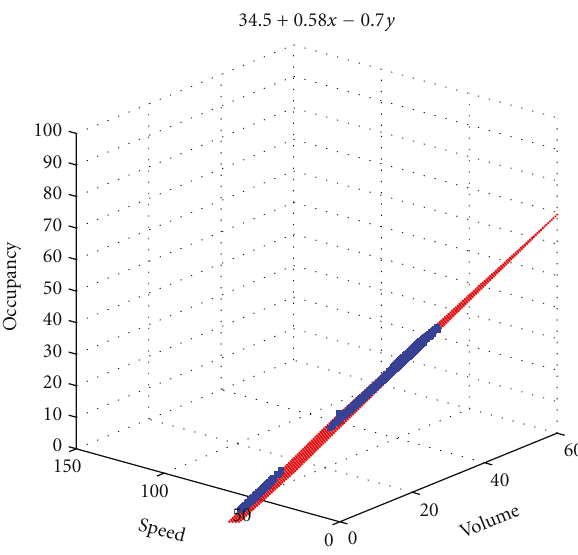
Figure 9: Regression plane for Dense tra ffi c.